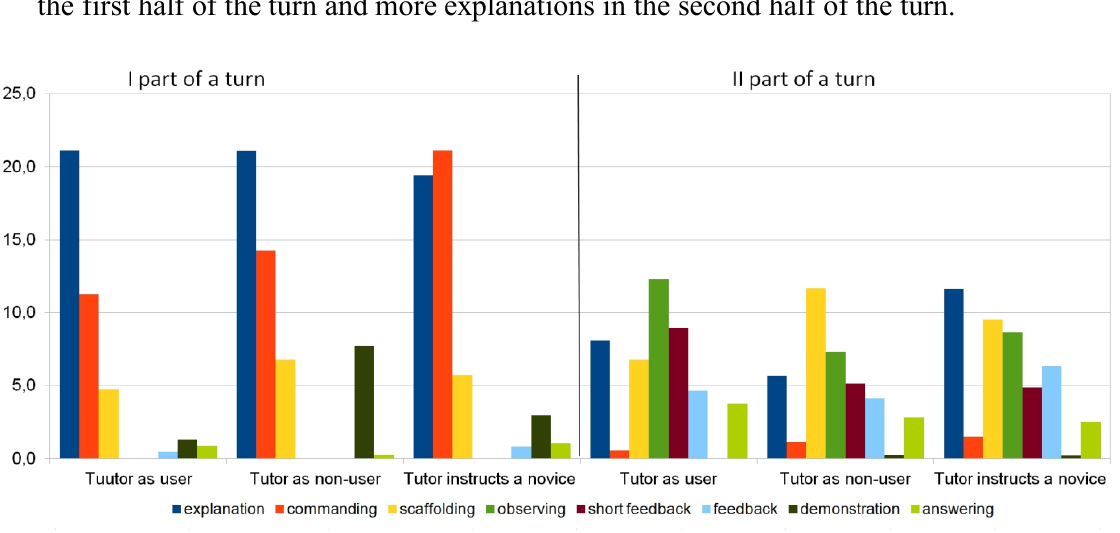
Figure 1 . Eight most frequently used techniques in case of tutors with different using experience (proportion of all the statements). The Figure does not include these six techniques whose average frequency of usage was less than in 1% of all the statements